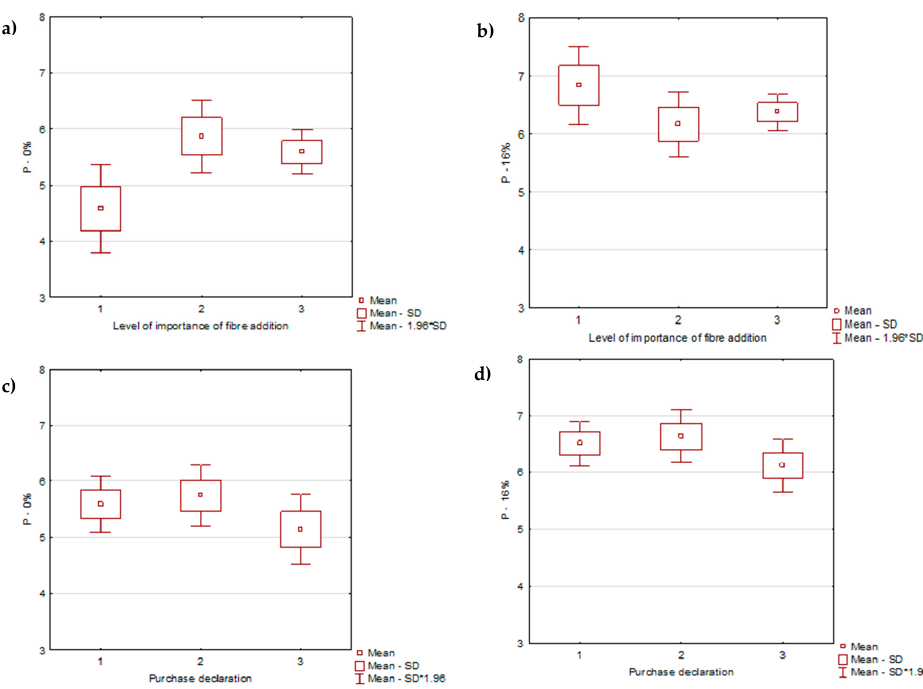
Figure 3. Results distribution of the liking evaluation of cooked pasta samples. ( a ): P-0 (control sample) and ( b ): P-16 (16% oat β -glucan fiber powder) in relation to the declared importance of fiber addition; ( c ): P-0 (control sample) and ( d ): P-16 (16% oat β -glucan fiber powder) in relation to the willingness